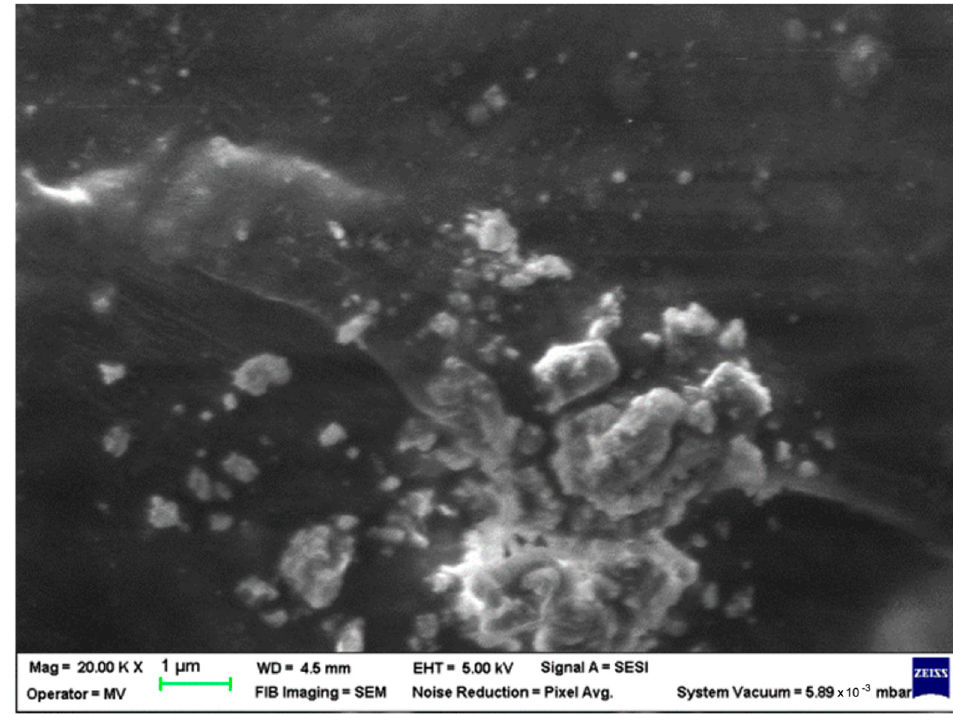
Figure 7. SEM micrographs of PET–PP–Al composite (M7) sample at T 0 (1 μ m scale).